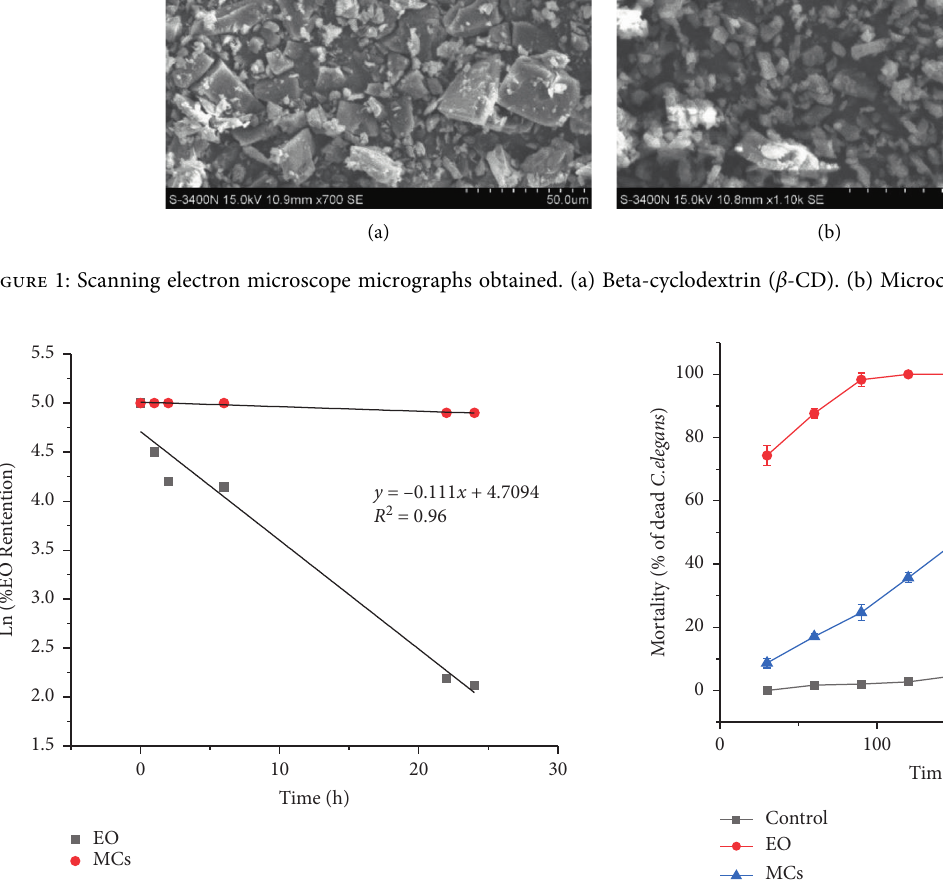
Figure 2: Comparative study of stability for total essential free oil (EO) and microencapsulated essential oil (MCs).